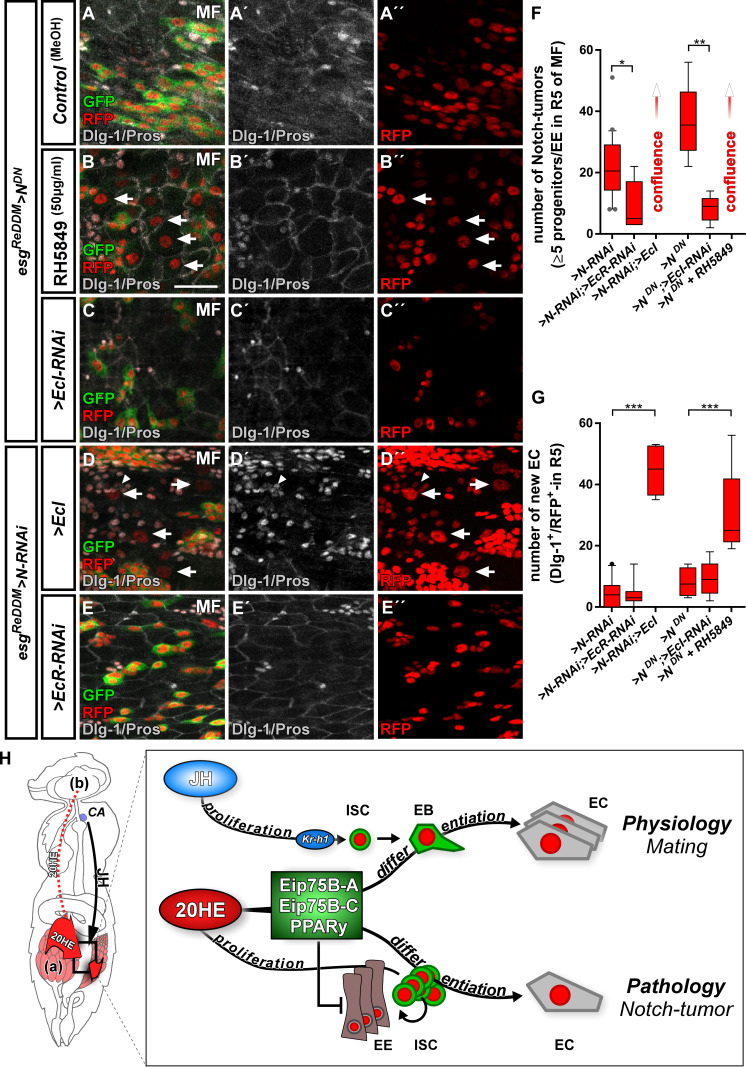
Ecdysone signaling promotes EC-fate in a Notch tumor paradigm.(A–E’’) Pharmacological and genetic manipulation of Ecdysone signaling. Adult PMG of MF with N-LOF (>N RNAi or > NDN) treated with MeOH as control (A–A’’) or RH5849 (B–B’’) to activate Ecdysone signaling. Arrowheads highlight newly generated Dlg-1+/RFP+-EC (B+B’’) after seven days of esgReDDM > NDN. (C–C’’) RNAi-mediated downregulation of EcI in esgReDDM > NDN, forced expression of >EcI (D–D’’) and >EcR RNAi (E–E’’) in esgReDDM > N RNAi MF after seven days of tracing. Arrowheads highlight newly generated Dlg-1+-EC (D+D’’), scale bars = 25 µm. (F) Quantification of ISC progeny encompassing ISC-like, EC and EE classified after tumor size in R5 PMG (n = 13,5,7,4,6,9). Error bars are Standard Error of the Mean (SEM) and asterisks denote significances from one-way ANOVA with Bonferroni's Multiple Comparison Test (*p<0.05, **p<0.01; ***p<0,001; ****p<0.0001). (G) Quantification of newly generated EC (Dlg-1+/RFP+) in R5 PMG (n = 13,5,7,4,6,9). Error bars are Standard Error of the Mean (SEM) and asterisks denote significances from one-way ANOVA with Bonferroni's Multiple Comparison Test (*p<0.05, **p<0.01; ***p<0,001; ****p<0.0001). (H) Model of 20HE and JH hormonal pathways influencing physiological and pathological turnover in the intestine. Upon mating, JH from the neuroendocrine CA (corpora allata, [Reiff et al., 2015]) as well as ovarian 20HE (a) synergize on progenitor cells in the posterior midgut of adult female flies. The source of 20HE could not be definitely determined in this current study and 20HE might as well stem from the brain (b). JH induces ISC proliferation through Kr-h1, whereas 20HE signaling transduced by Eip75B-A /- C/PPARγ, ensures that newly produced EB differentiate into EC. New EC lead to a net increase in absorptive epithelium and thus ensures physiological adaptation of intestinal size to the new metabolic energy requirements of pregnancy. In the adult intestine, early steps of tumor-pathology are recapitulated when EC fate is inhibited by the lack of Notch signaling in progenitors (Patel et al., 2015). Notch mutant ISC divisions only produces ISC-like progenitors and EE. We show in this study that 20HE signaling, through Eip75B-A /- C/PPARγ, is capable to alleviate Notch tumor growth by driving intestinal progenitors into post-mitotic absorptive EC fate.Figure 7—source data 1.Data from Figure 7.Panel F,G experimental data.